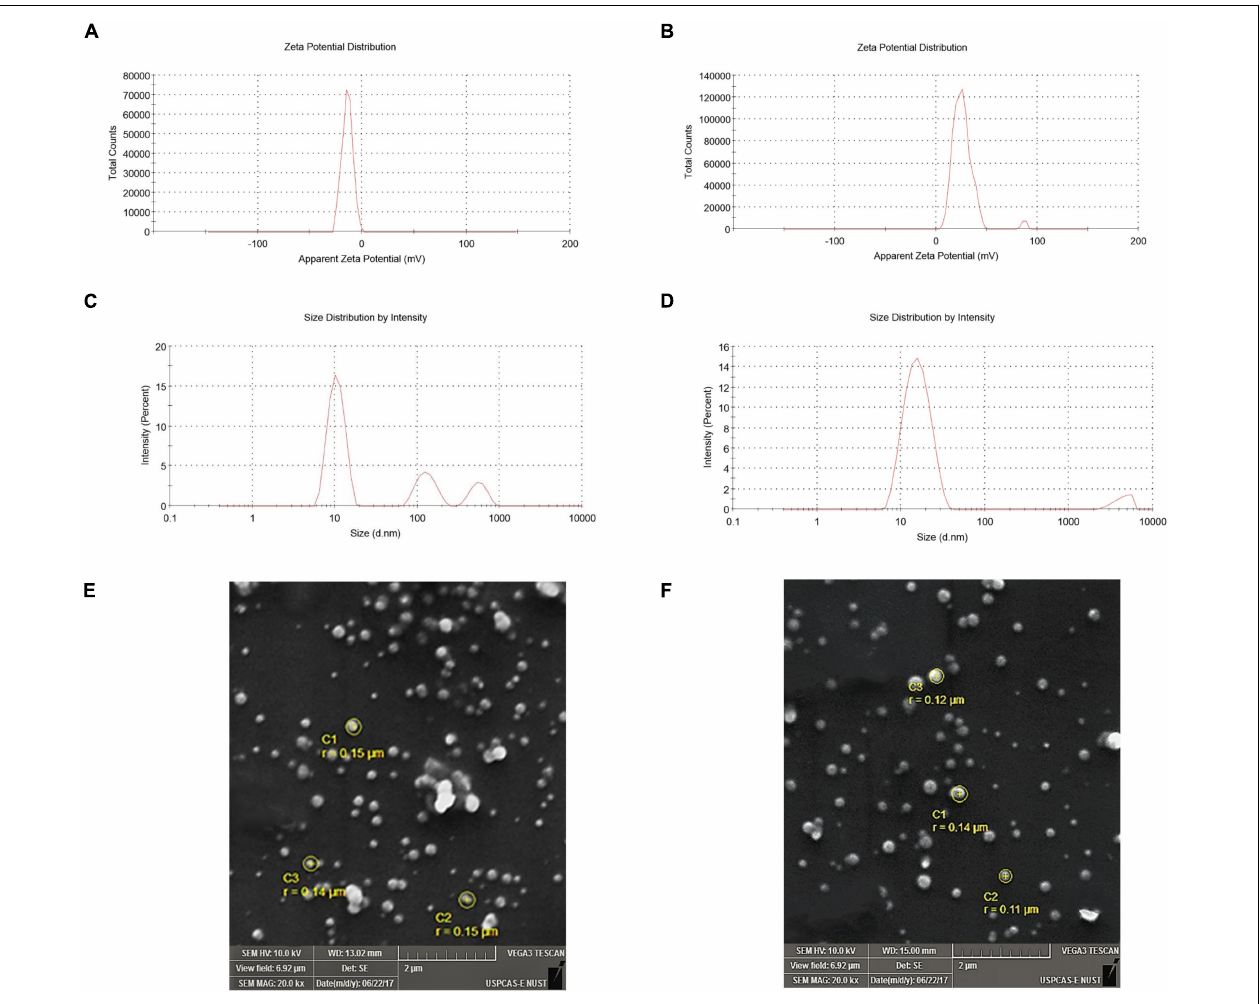
FIGURE 3 | Zeta potential and zeta size of solid lipid nanoparticles. (A) Zeta potential of blank solid lipid nanoparticle (-14.1 mV) and (B) zeta potential of diosgenin incorporated solid lipid nanoparticles (-26.0 mV) depicting stability. (C) Zeta size of blank solid lipid nanoparticles (436.5 nm) and (D) zeta size of diosgenin incorporated solid lipid nanoparticles show average size range. SEM images of blank and diosgenin loaded solid lipid nanoparticles were taken at × 20,000 magnifications with size ranging up to 200 nm. (E) Blank solid lipid nanoparticles. (F) Diosgenin incorporated solid lipid